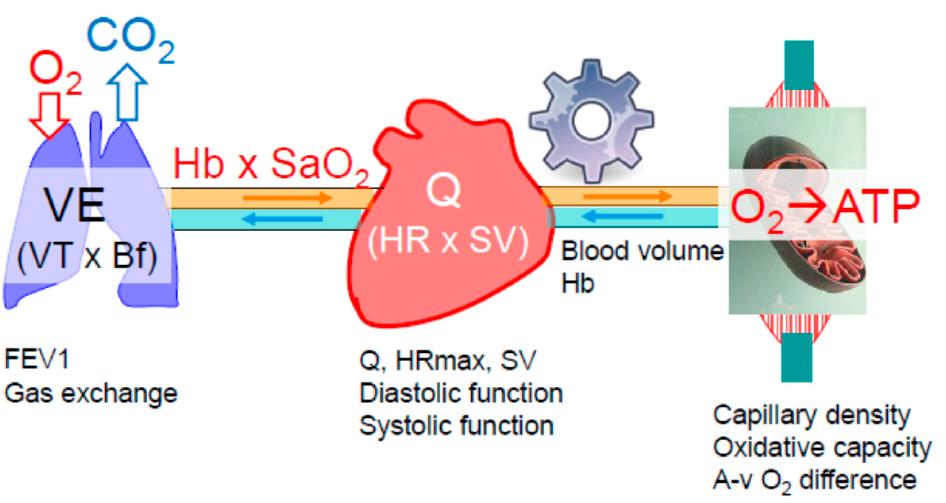
Figure 2. The lung–heart–muscle axis involved in oxygen delivery and utilization. Main cardiorespiratory parameters specifying organ function at rest and during exercise: minute ventilation (VE), cardiac output (Q), and oxygen extraction in the skeletal muscle. Parameters listed below the organs represent those which are primarily affected by the aging process. Oxygen, O 2 ; carbon dioxide, CO 2 ; tidal volume, VT; breathing frequency, Bf; hemoglobin concentration, Hb; arterial oxygen saturation, SaO 2 ; heart rate, HR; adenosine triphosphate,